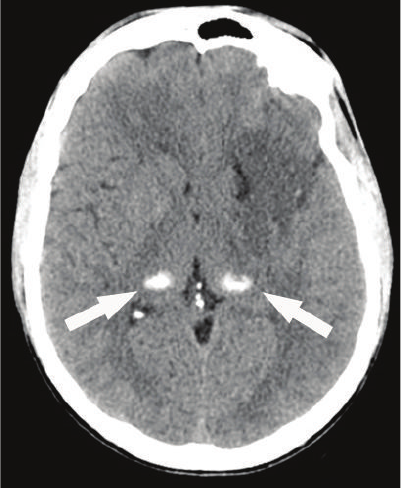
Figure9:ApatientwithatypicalWernersyndrome(i.e.,aprogeroid syndrome with Werner syndrome phenotype but without typical RECQL2 mutation) due to a LMNA mutation showing bilateral thalamic calcifications on CT